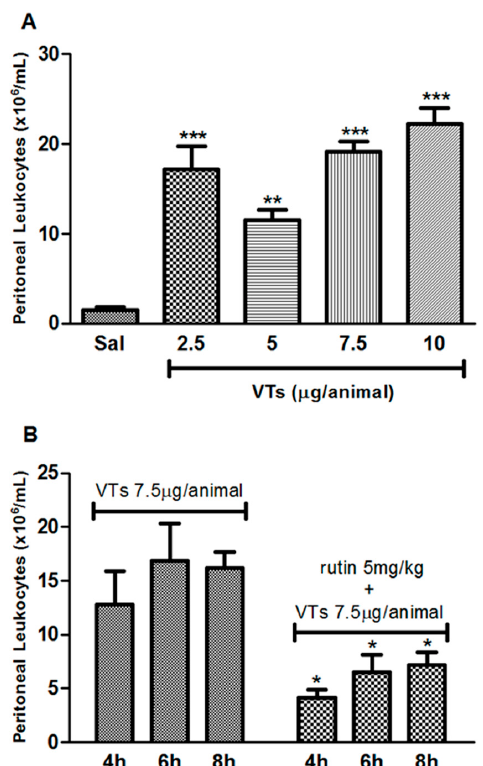
Figure 4. Effect of dose and time-kinetics of Tityus serrulatus venom-induced inflammation. Effect of venom dose on inflammatory response in envenomation-induced peritonitis model in mice. Animals